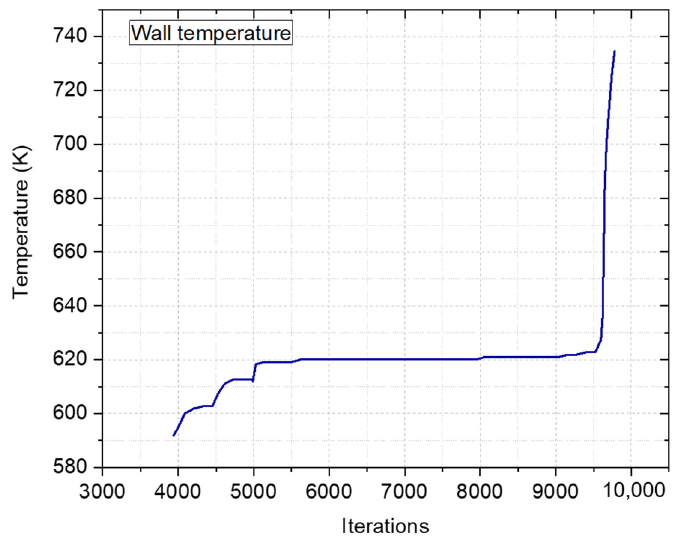
Figure 3. Evolution of wall temperature with iterations.